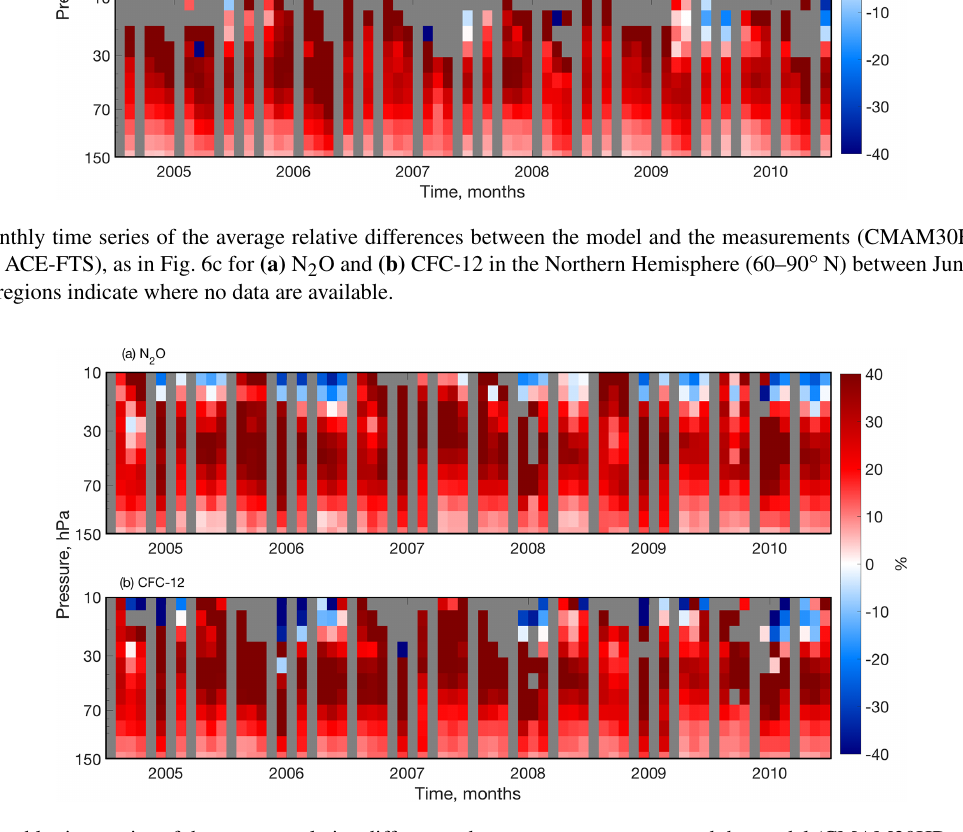
Figure 10. A monthly time series of the average relative differences between measurements and the model (CMAM30HR minus ACE-FTS, divided by ACE-FTS), as in Fig. 6c for (a) N 2 O and (b) CFC-12 in the Southern Hemisphere (60–90 ◦ S) between June 2004 and May 2010. The grey regions indicate where no data are